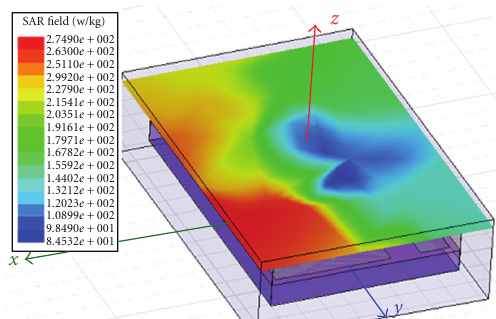
Figure 5: Simulated SAR distribution over the x - y plane ( z = the interface between the antenna superstrate and muscle block).